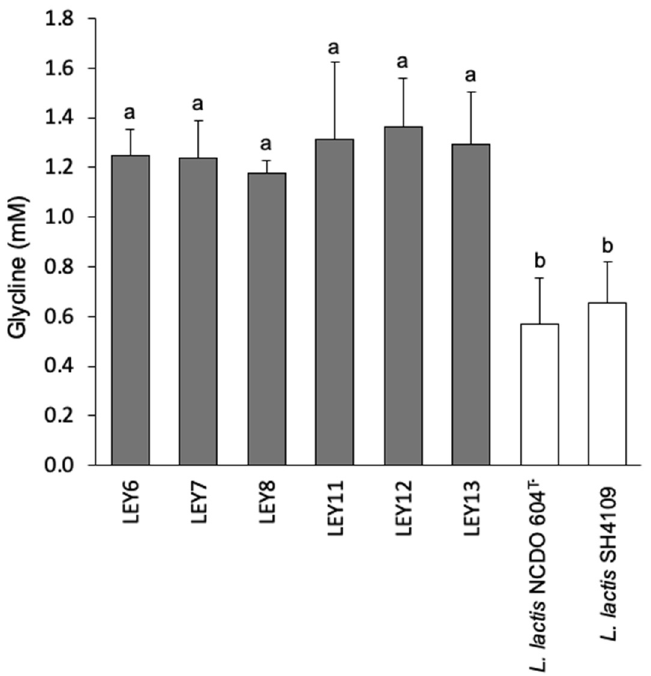
Figure 3. Proteolytic activity of the GABA-producing L. lactis strains as determined by the O- phthaldialdehyde (OPA) assay. Proteolytic activity was recorded as millimoles of glycine released after incubation in skimmed cow’s milk at 30 °C for 24 h, using a glycine calibration curve. The strains used as positive control were L. lactis NCDO 604 T and L. lactis SH4109. Bars with different letters indicate significant differences ( p < 0.05).